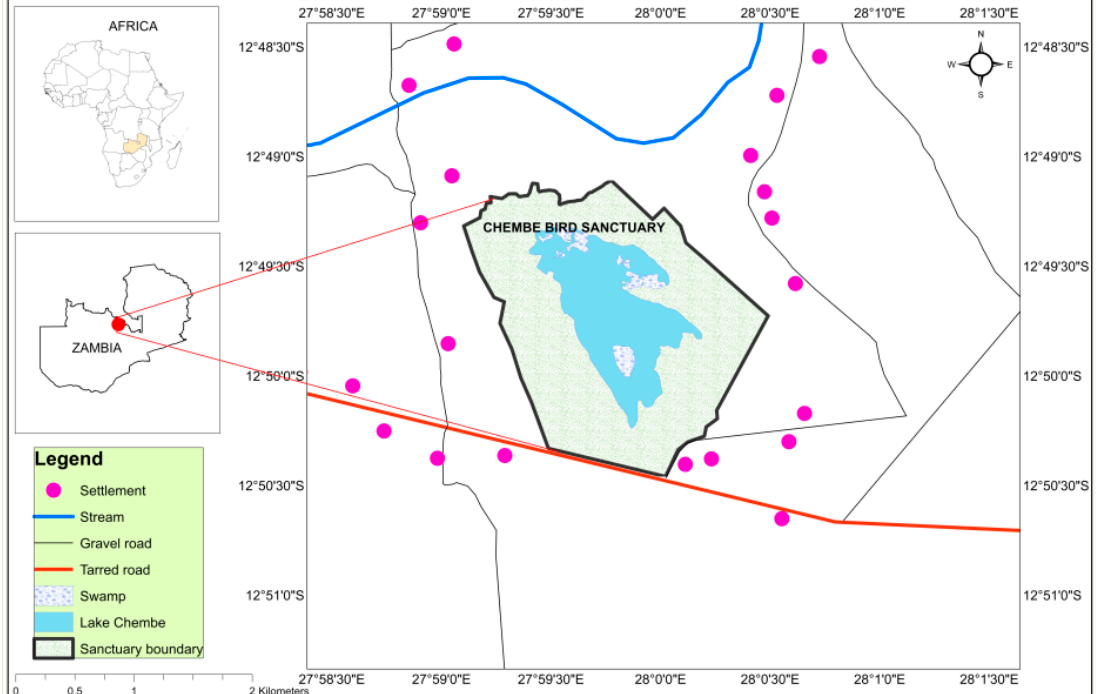
Figure 1. Locational map of the study area of Chembe Bird Sanctuary, Kalulushi, Zambia.